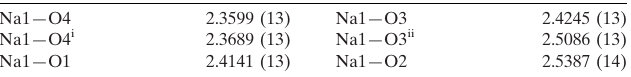
Selected bond lengths (A˚